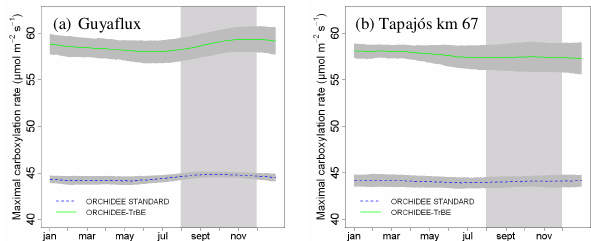
Figure 6. V c,max ( µ mol CO 2 m -2 s -1 ) mean annual time profile plotted along with Fig. 6. V c,max (µmolCO 2 m − 2 s − 1 ) mean annual time profile plot- standard deviation (grey) at (a) Guyaflux 2004-2009 and (b) Tapajós km 67 2002- ted along with standard deviation (grey) at (a) Guyaflux 2004– 2004 standard ORCHIDEE and ORCHIDEE-TRBE. The dry period (<100 mm 2009 and (b) Tapaj´os (km 67) 2002–2004 standard ORCHIDEE and month -1 ) is shaded. ORCHIDEE-TrBE. The dry period ( < 100mmmonth − 1 ) is shaded.